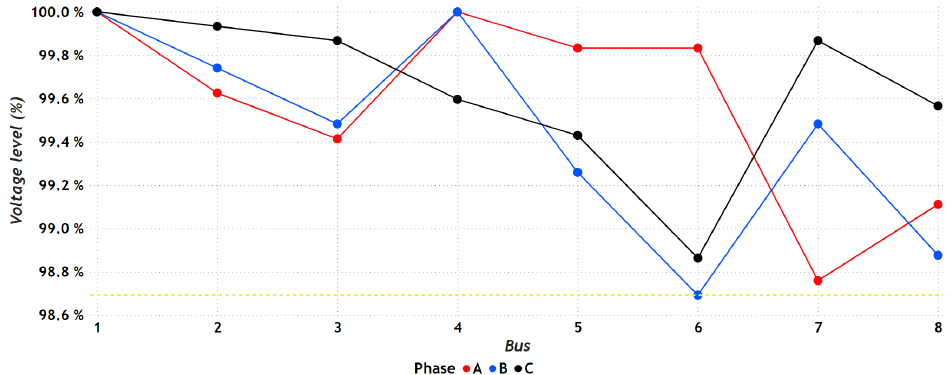
Figure 12. Behavior of the voltage profiles in the three-phase 8-bus distribution system under an unbalanced load scenario.